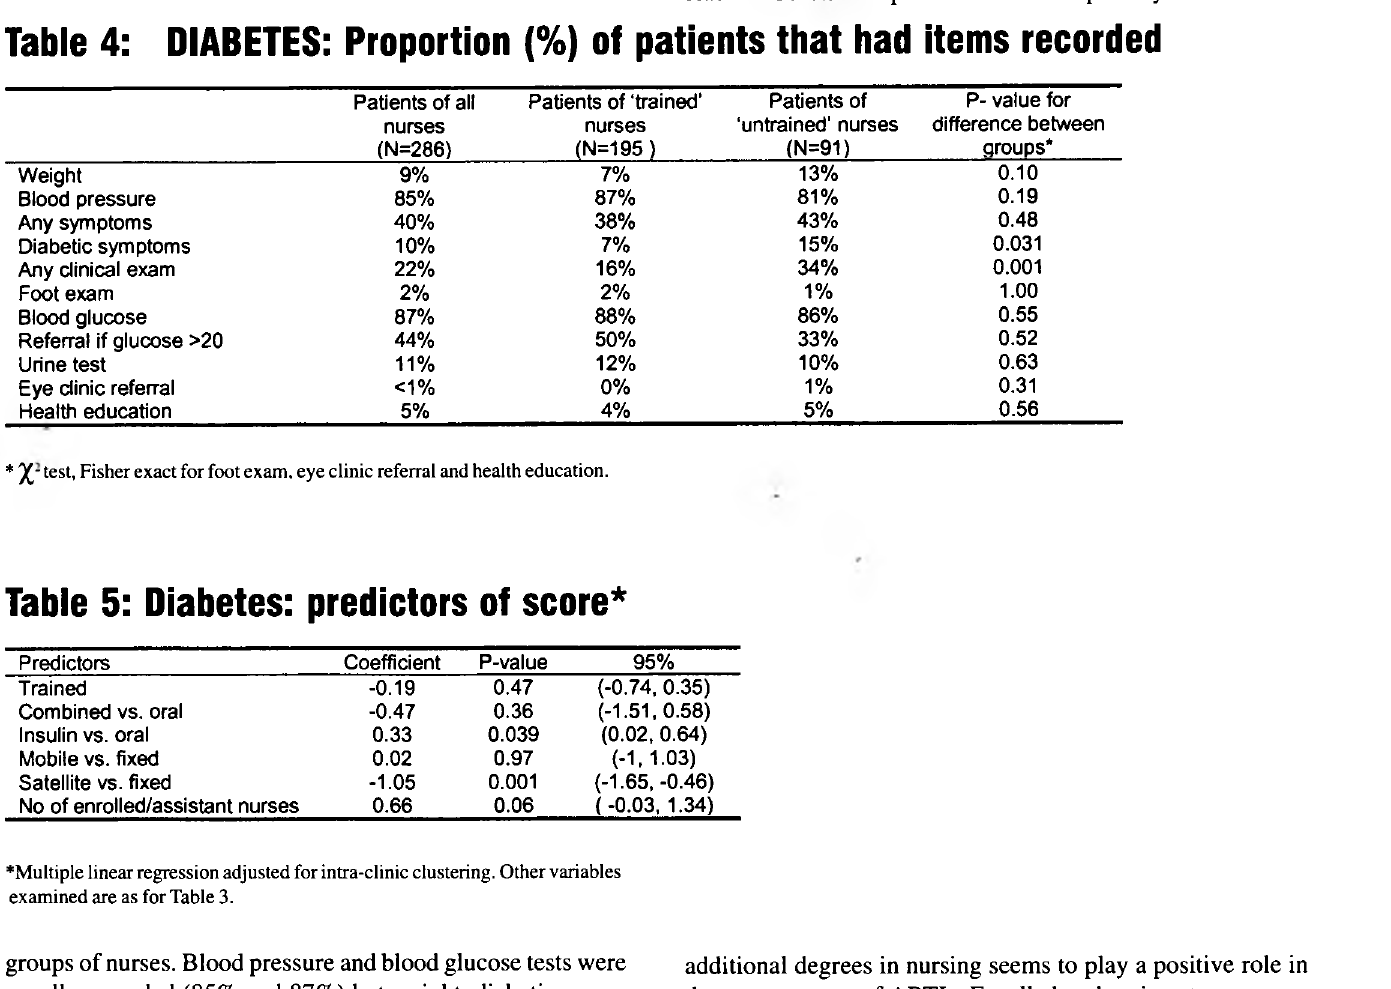
Table 5: Diabetes: predictors of score*